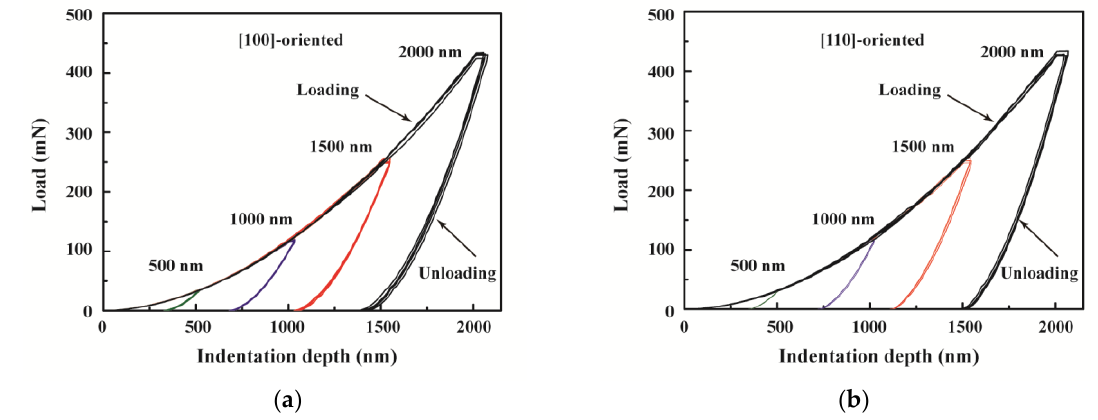
Figure 2. Load–indentation depth curves at different maximum depths for ( a ) the [100]-oriented PIN–PMN–PT bulk single crystal and ( b ) the [110]-oriented PIN–PMN–PT bulk single crystal during